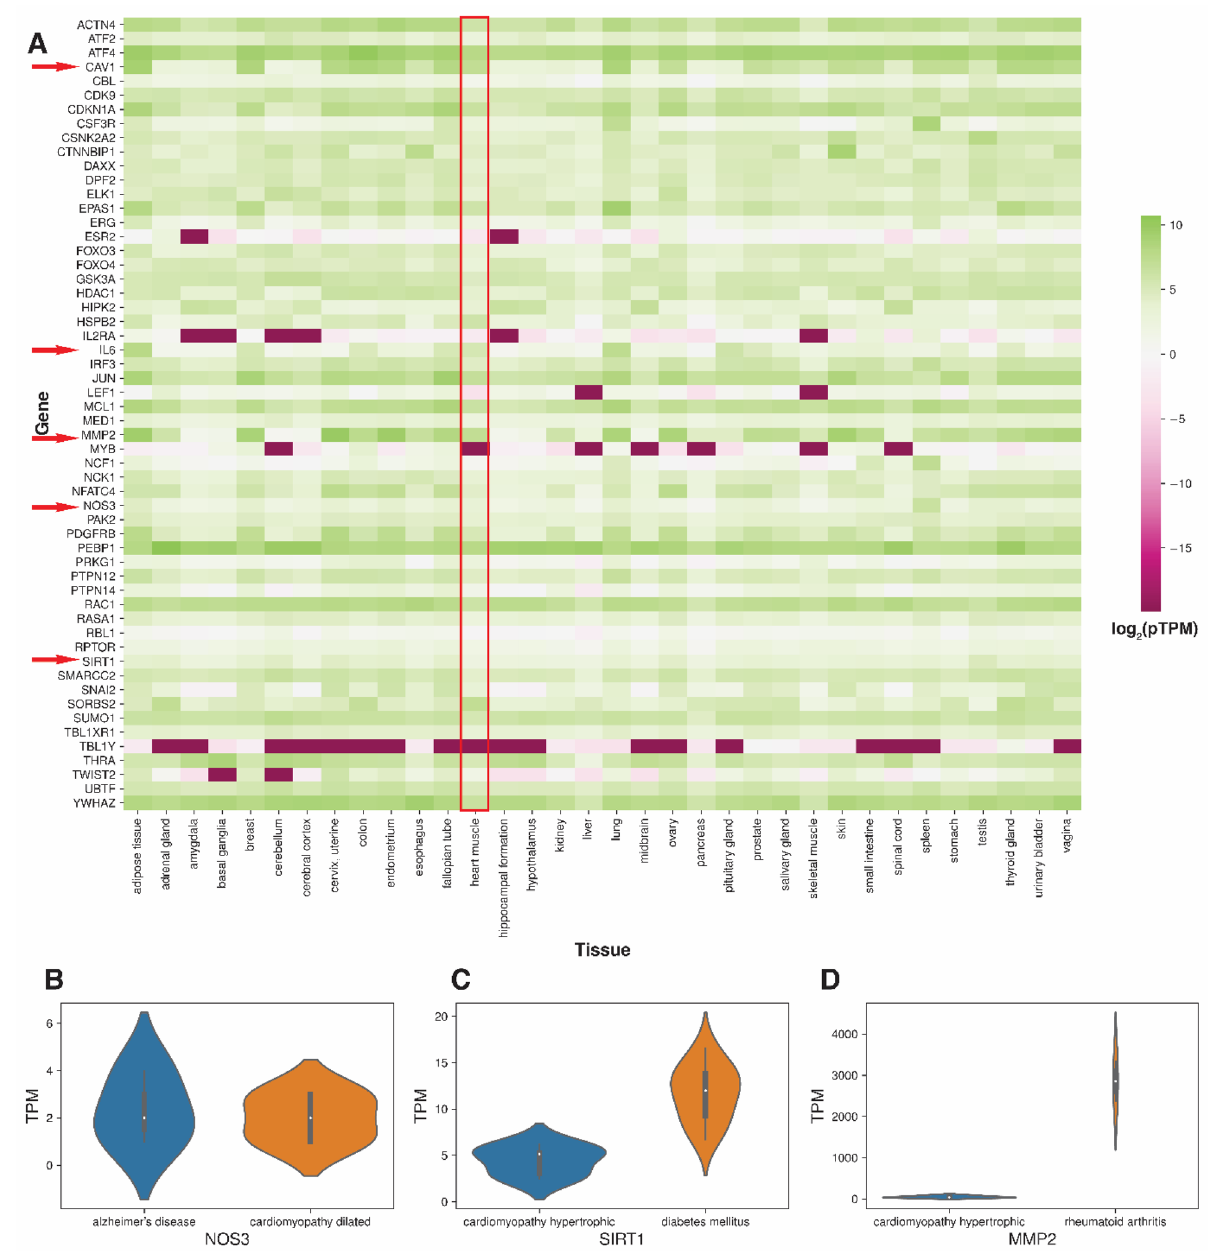
Figure 5. Tissue expression of candidate candidates: Overview of the tissue specific RNA expression of the candidate genes in cardiomyopathy-centric diseasome. ( A ) The protein-transcript per million (pTPM) expression values of candidate genes across major tissue into GTEx dataset of the Human Protein Atlasdatabase. In the heatmap, values are log2 transformed with green color showing abundant transcripts while pink color depicting extremely low expressed transcripts. Red arrows point to important candidates observed in the study. Heart muscle tissue is highlighted with red box. ( B ) A violinplot shows the expression of NOS3 gene in Alzheimer’s and dilated cardiomyopathy. Transcript per million (TPM) of NOS3 derived from Brain and heart tissues (PRJEB28518 and PRJNA494688) were used. ( C ) Tissue specific expression of SIRT1 gene in hypertrophic cardiomyopathy and Diabetes mellitus. Expression of SIRT1 (TPM) was derived from dermal endothelial and heart tissues (PRJNA352990 and PRJNA358470). ( D ) MMP2 gene expression in rheumatoid arthritis and hypertrophic cardiomyopathy from SRP009315 and PRJNA352990